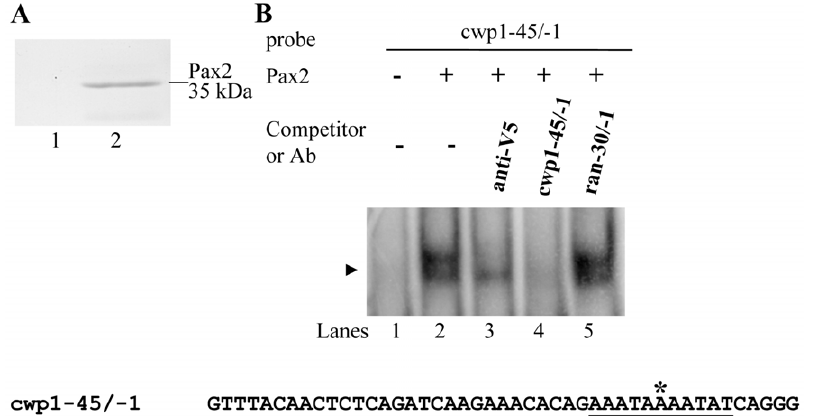
Figure 4. DNA-binding ability of Pax2 revealed by electrophoretic mobility shift assays. (A) Western blot analysis of recombinant Pax2 protein with a V5 tag at its C terminus purified by affinity chromatography. The purified Pax2 protein is detected by anti-V5-HRP antibody (lane 2). E. coli lysate with the vector only (pET101/D-TOPO) was used as a negative control and no detection was observed for this control with anti-V5-HRP antibody (lane 1). (B) Detection of Pax2 binding sites. Electrophoretic mobility shift assays were performed using purified Pax2 and the 32 P-end- lableled oligonucleotide probe cwp1-45/ 2 1 ( 2 45 to 2 1 relative to the translation start site of the cwp1 gene). Components in the binding reaction mixtures are indicated above the lanes. The Pax2 binding specificity for the cwp1-45/ 2 1 probe was confirmed by competition and supershift assays. Some reaction mixtures contained 200-fold molar excess of cold oligonucleotides cwp1-45/ 2 1 or ran-30/ 2 1 or 0.8 m g of anti-V5 antibody, as indicated above the lanes. The arrowhead indicates the shifted complex. The transcription start site of the cwp1 gene determined from 24-h